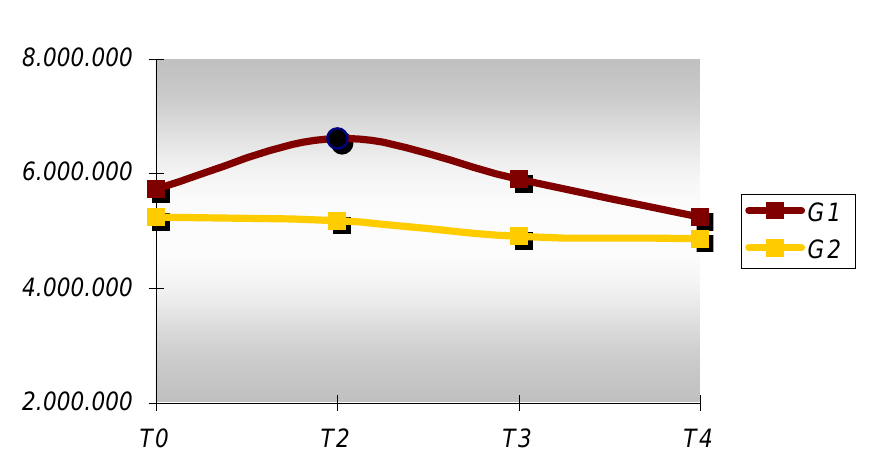
Figure 4: Distribution of the red blood cells count values (hem/µl) of the twelve animals observed (G1 = 0.25 mg/kg and G2 = 0.4 mg/animal) at the four different moments studied (T0 = pre-envenomation; T2 = 6h after envenomation; T3 = 24h after envenomation; and T4 = 72h after envenomation) (cid:122) = p <0.05. Botucatu, São Paulo, Brazil, 2003.